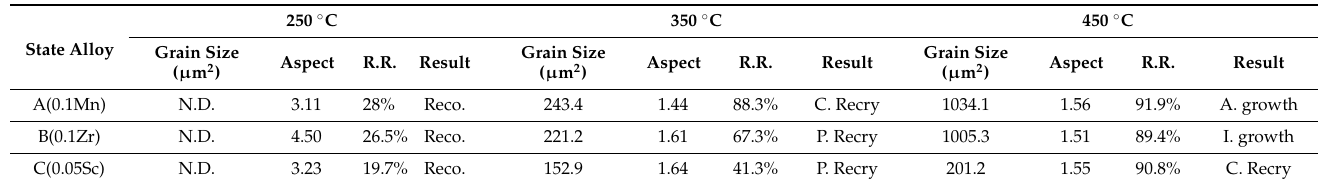
Table 2. Recrystallization fraction and microstructures of Al-Mg alloys with various annealing. 250 ◦ C State Alloy Grain Size Grain Size ( µ m 2 ) Aspect R.R. Result ( µ m 2 ) Aspect R.R. Result